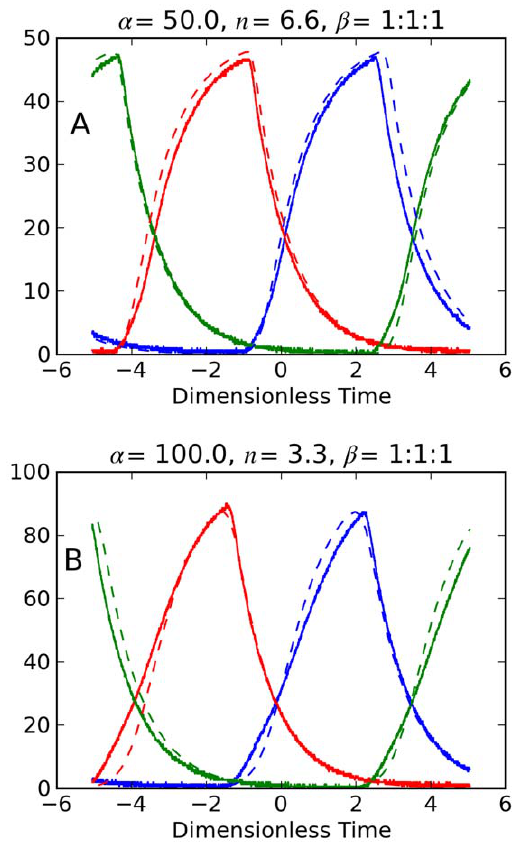
Figure 5. Electronic repressilator dynamics. Normalized voltages x i measured from RGN repressilator circuit (solid) and numerical predictions (dashed). b -ratio =1:1:1. Panel A ( a =50, n =6.6); Panel B ( a =100, n